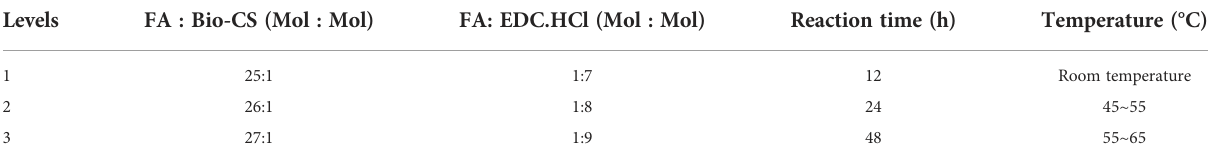
TABLE 2 Synthetic Bio-GC orthogonal experiment design. Levels